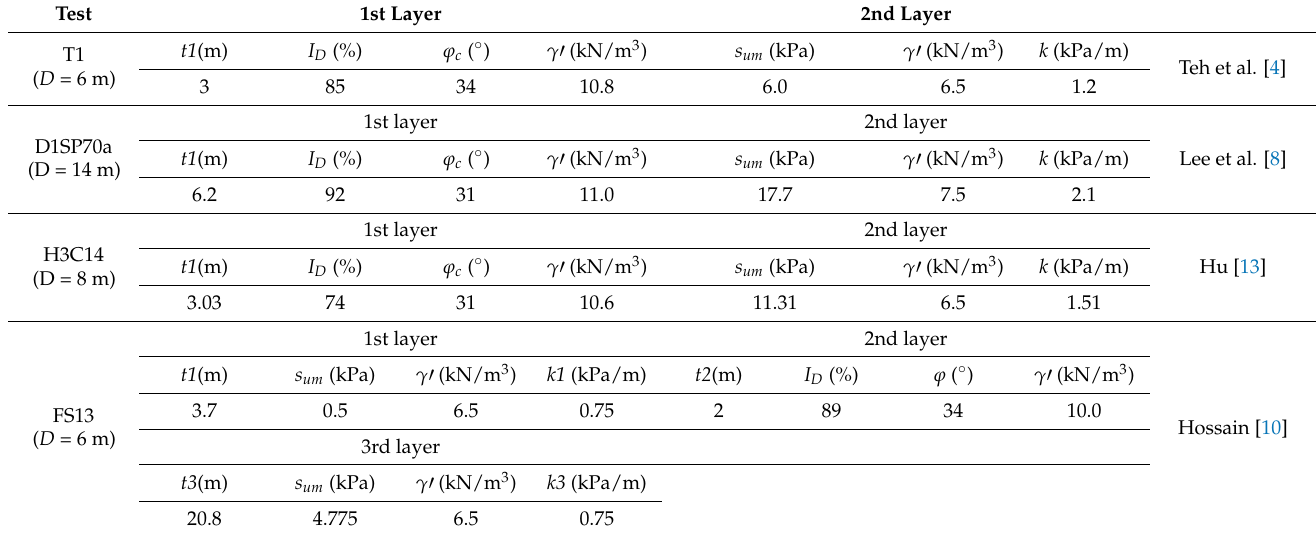
Table 1. Soil properties used in centrifuge